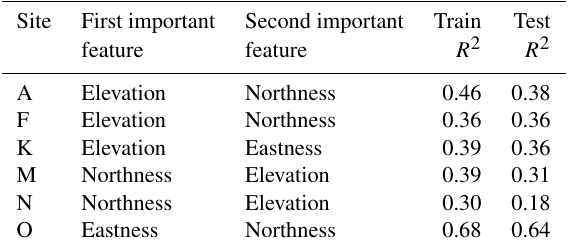
Table 3. The first and second most important features from decision tree regressed between topographical features and snow depth in the open